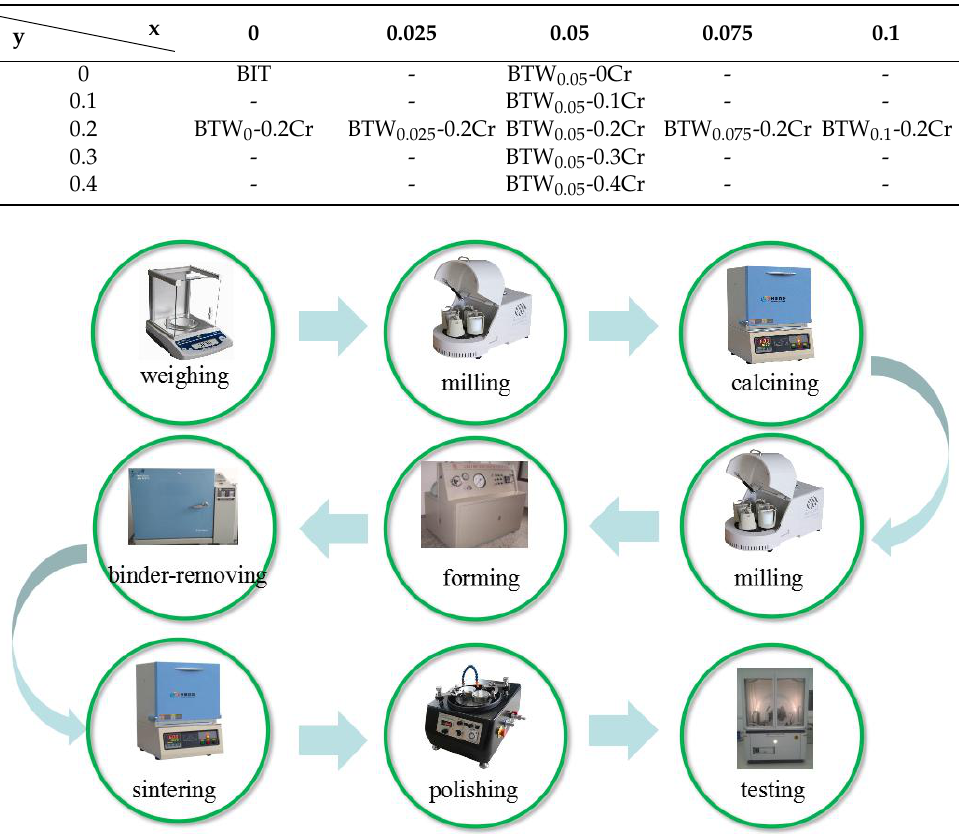
Figure 2. A conventional solid reaction process designed for synthesizing BTWC ceramics.